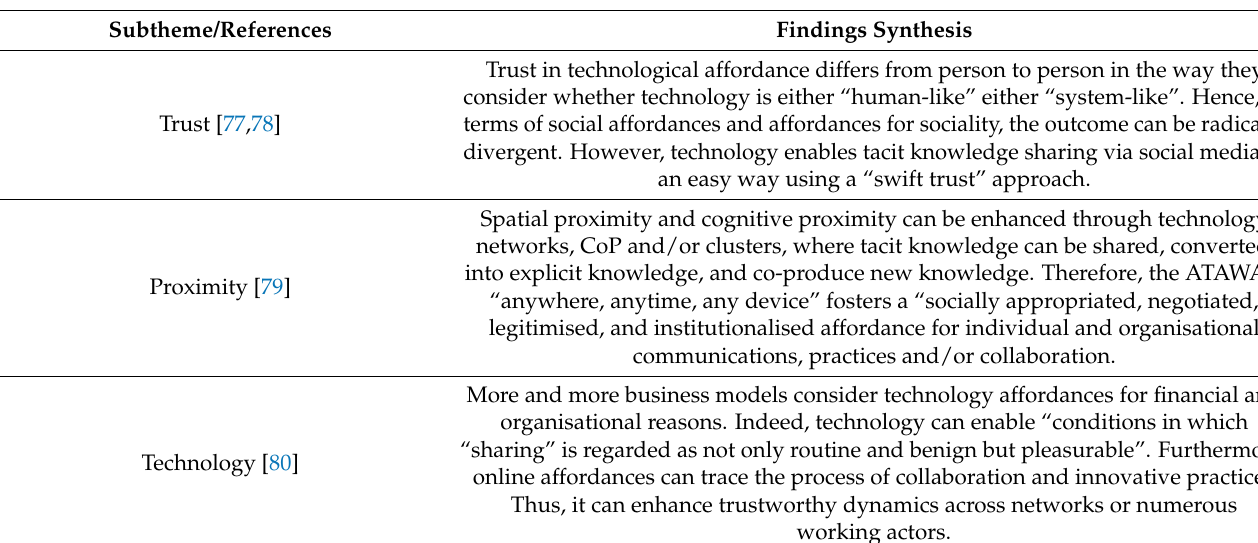
Table 4. Affordance and mobile devices, or creativity on the